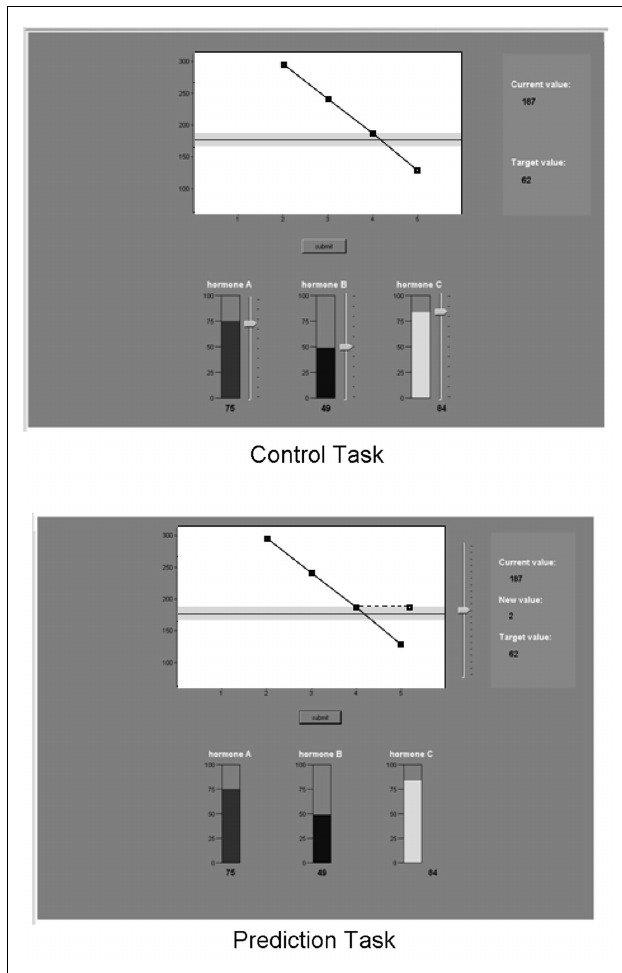
FIGURE 1 | Screen-shot of a learning trial for predictors and